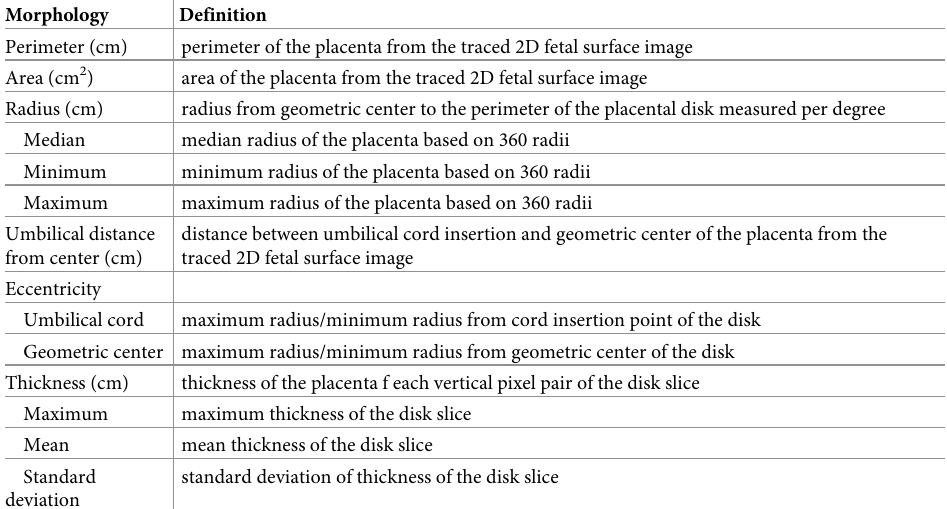
Table 1. Placenta morphology measure